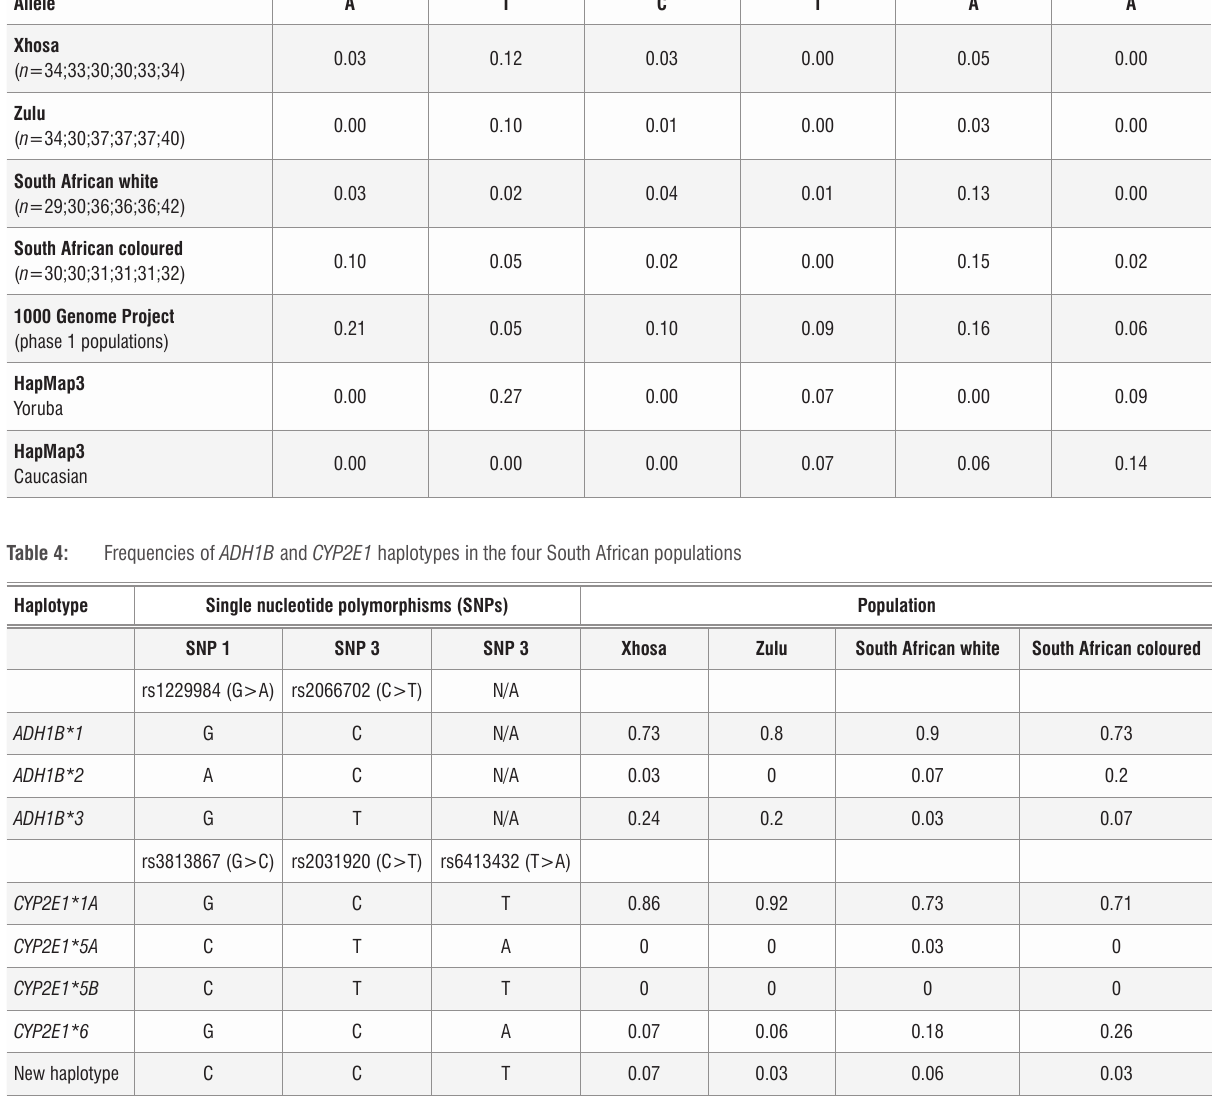
Table 3: Distribution of allele frequencies in the four South African population groups, the 1000 Genome Project and two HapMap3 populations